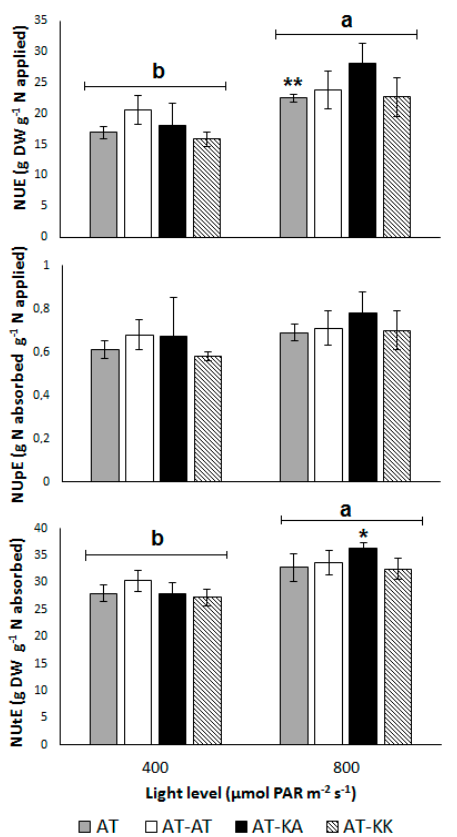
Figure 1. Nitrogen-use (NUE; top), -uptake (NUpE; middle), and -utilization efficiency (NUtE; bottom) for each treatment under medium or high light levels. Bars represent mean ± s.e. of four replicates. Asterisks denote the level of significance (*: p < 0.05; **: p < 0.01) for the difference in the same treatment across light levels. (a, b) Letters above light groups denote significant differences ( p < 0.05) between light levels.